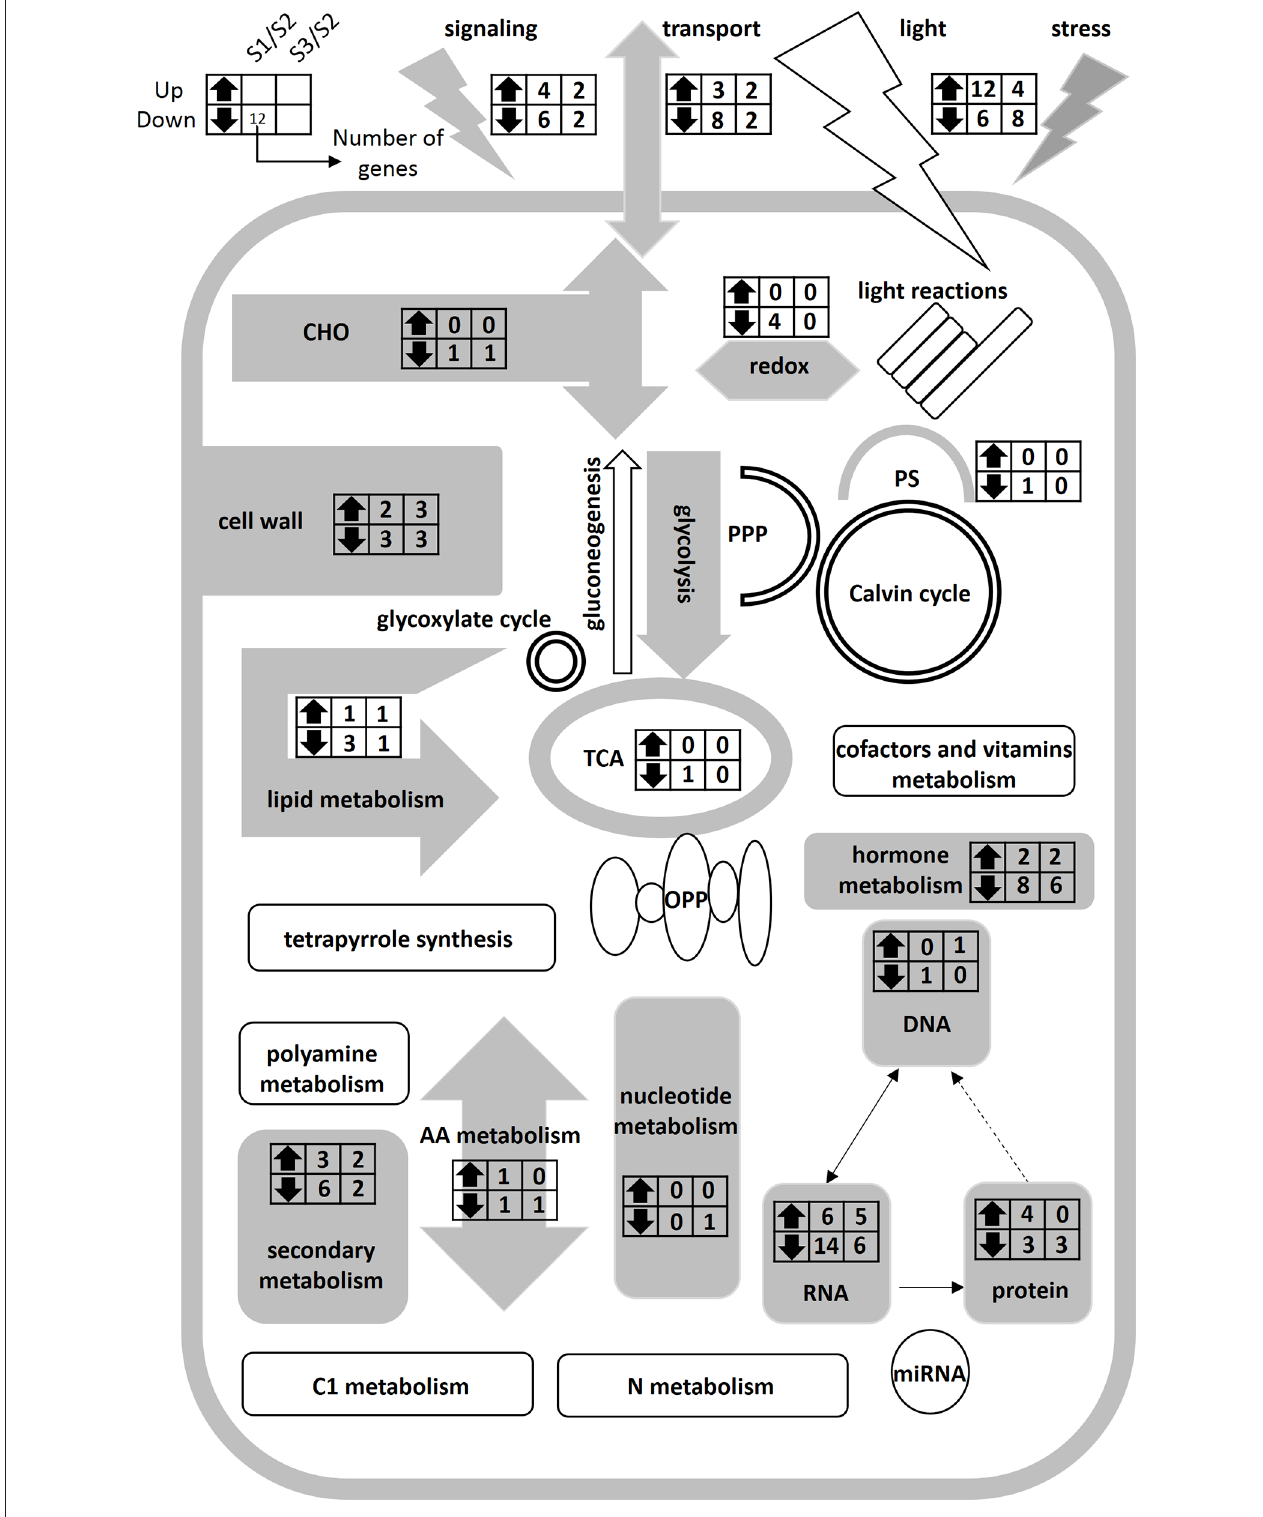
FIGURE 5 | Schematic representation of primary metabolism of poplar roots at different forms of nitrogen. Gray charts represent significantly differentially expressed genes in the metabolic pathways. White charts represent the genes without significantly different expression in the metabolic pathways. The left and right columns represent the S1/S2 and S3/S2 at the transcriptional level, respectively. Up- and down-facing triangles represent an increase and decrease in transcripts. The digital in columns represent the number of change genes. It can be found that there was no significantly difference gene in nitrogen metabolic pathway.